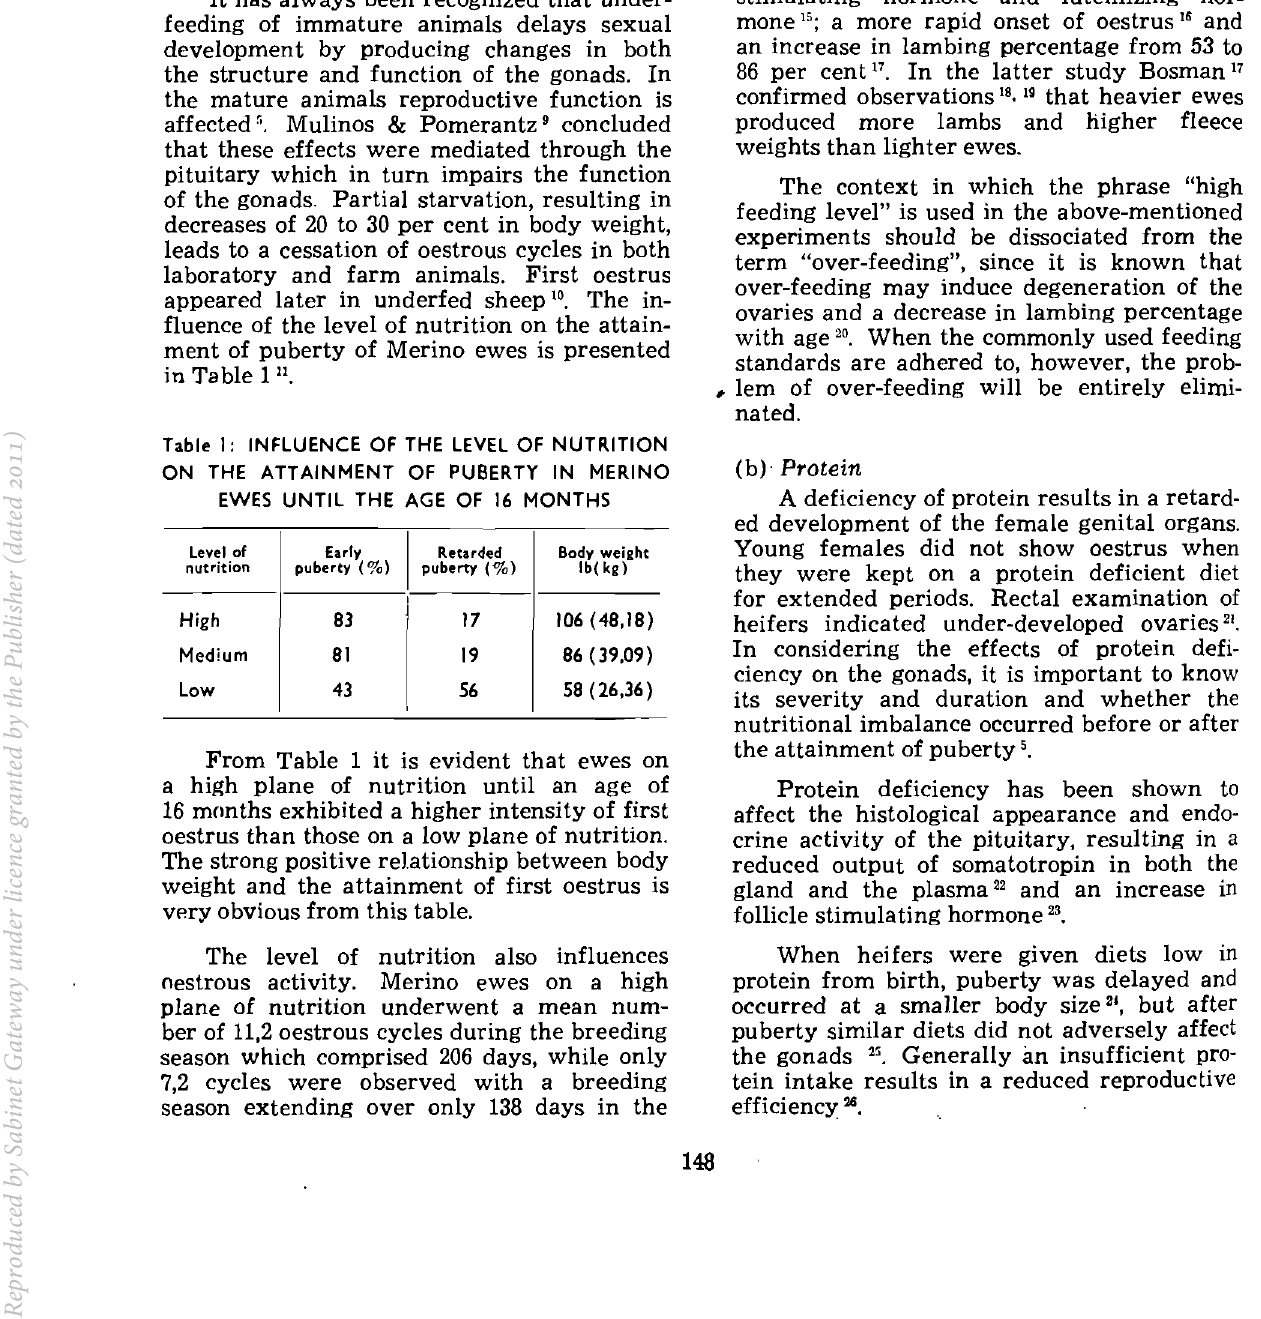
Table I: INFLUENCE OF THE LEVEL OF NUTRITION ON THE ATTAINMENT OF PUBERTY IN MERINO EWES UNTIL THE AGE OF 16